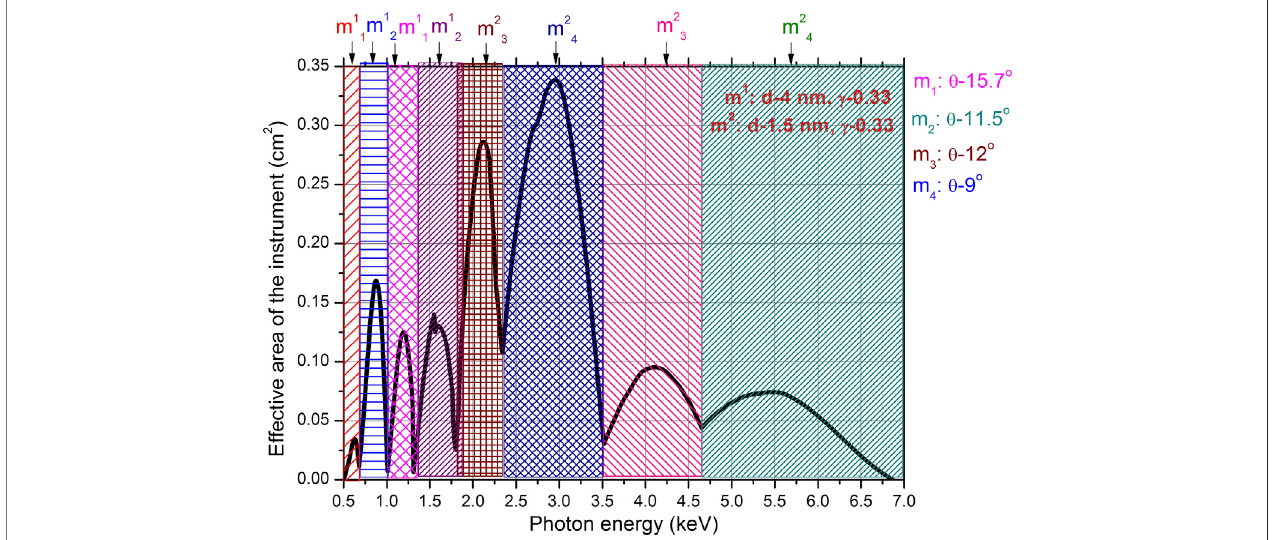
FIGURE5| Effectiveareaofthespectrometercombinedinallfourchannels.m # representstwomulti-layermirrorswithdifferentcoatingspeci fi cations.m # indicates the four different angle of incidences of the mirror with respect to the optical axis as given in the inset.